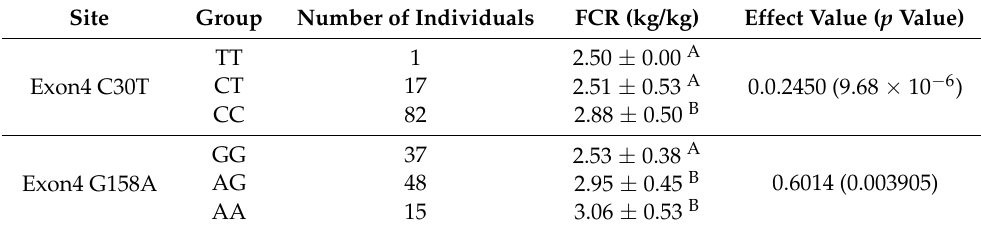
Table 5. Feed conversion ratio data of different genotypes at each SNP